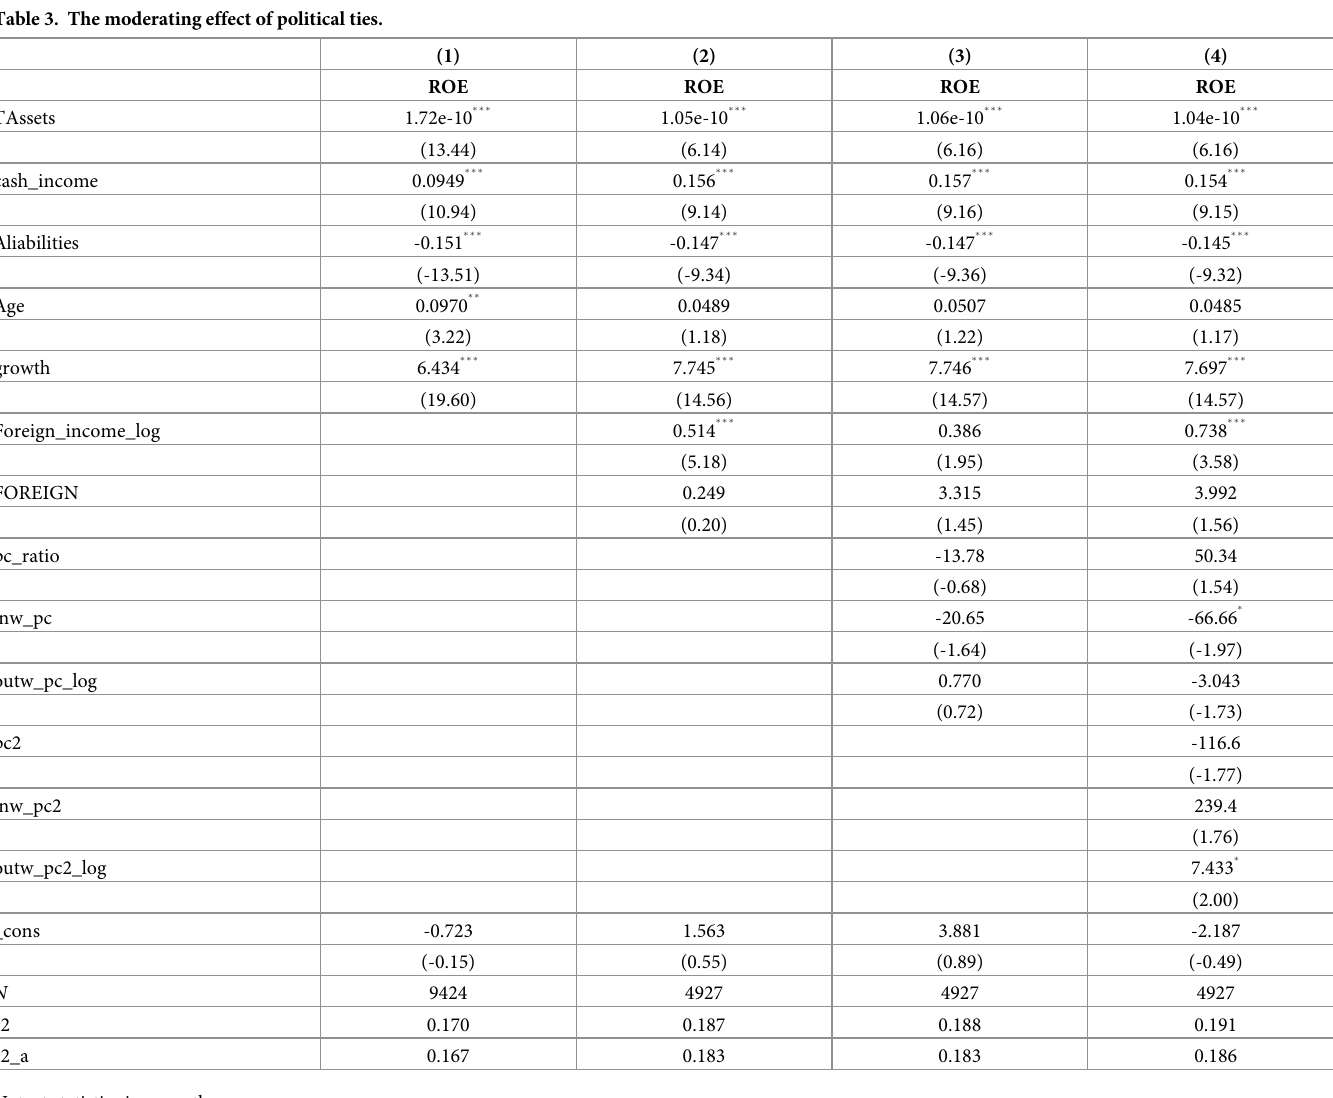
Table 3. The moderating effect of political